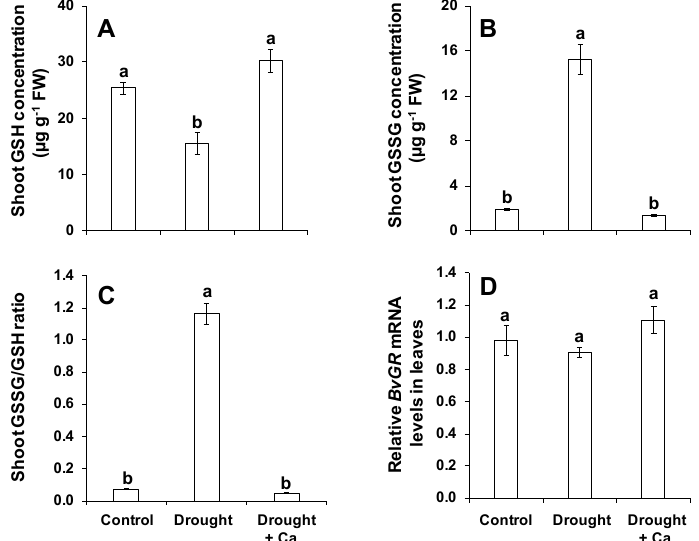
Figure 6. Influence of foliar application of Ca 2 + on shoot glutathione pool and on the expression of glutathione reductase in sugar beet exposed to drought stress. ( A ) Shoot GSH concentration; ( B ) shoot GSSG concentration; ( C ) shoot GSSH/GSH ratio; and ( D ) relative BvGR mRNA levels in leaves. Plants